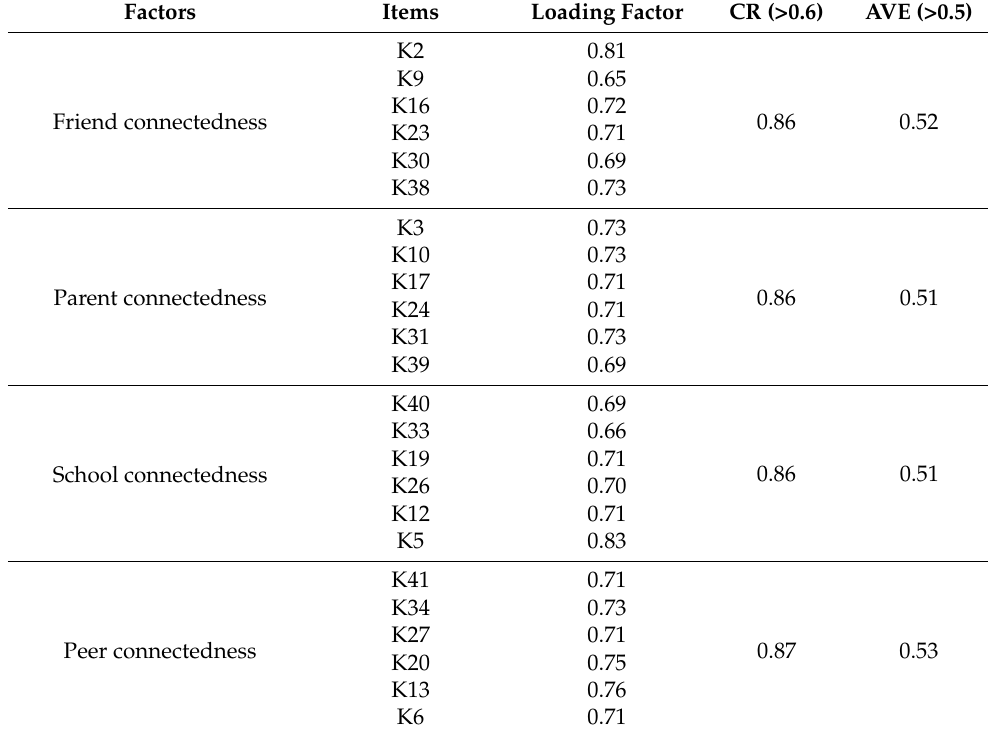
Table 5. Average Variance Extracted, Composite Reliability, and Factor Loadings for adolescent measurement model (n =